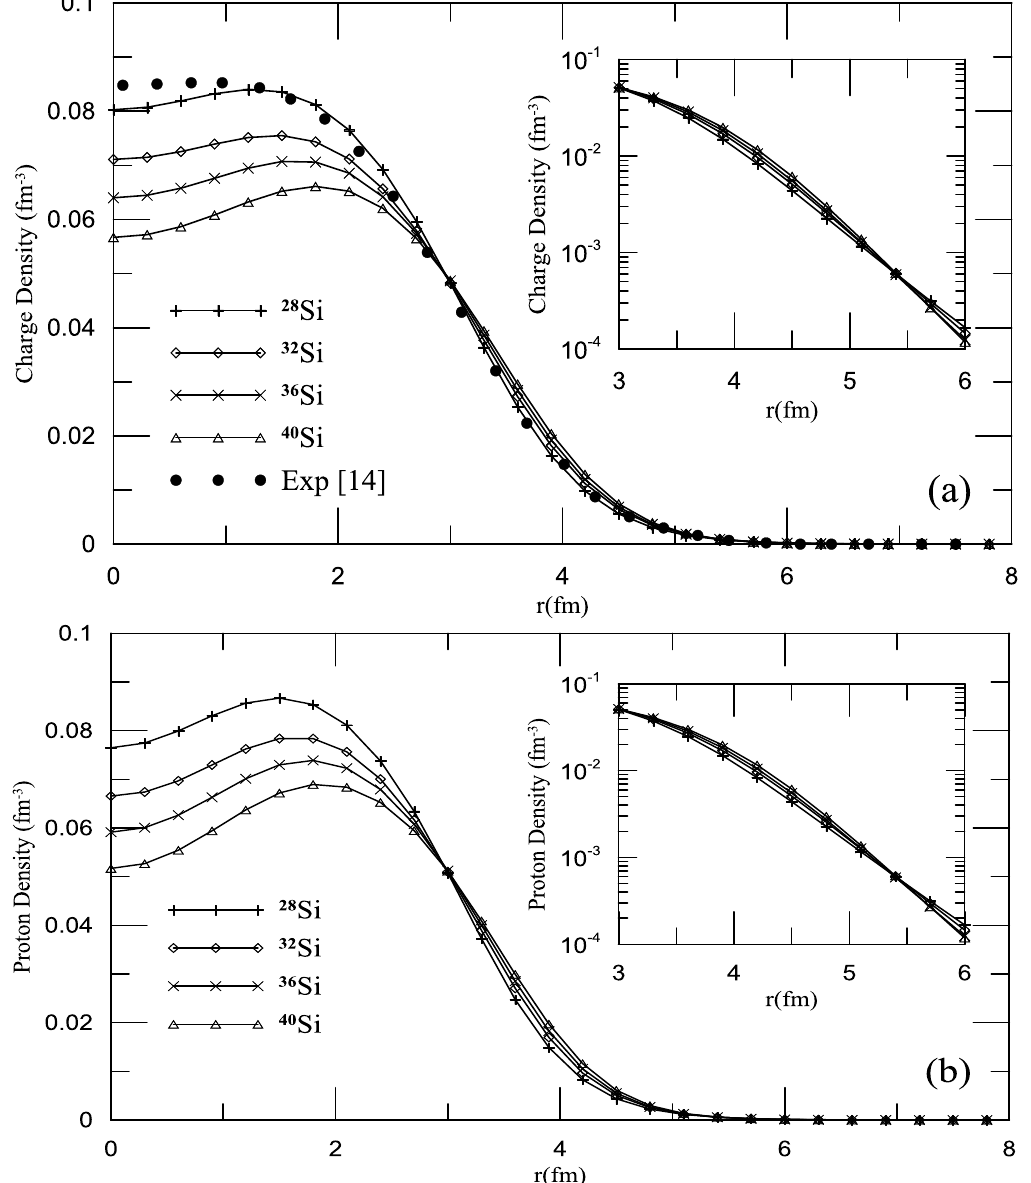
Fig.3: Density curves of different Si- isotopes calculated by the SkX parameterization; (a) charge density, (b) proton